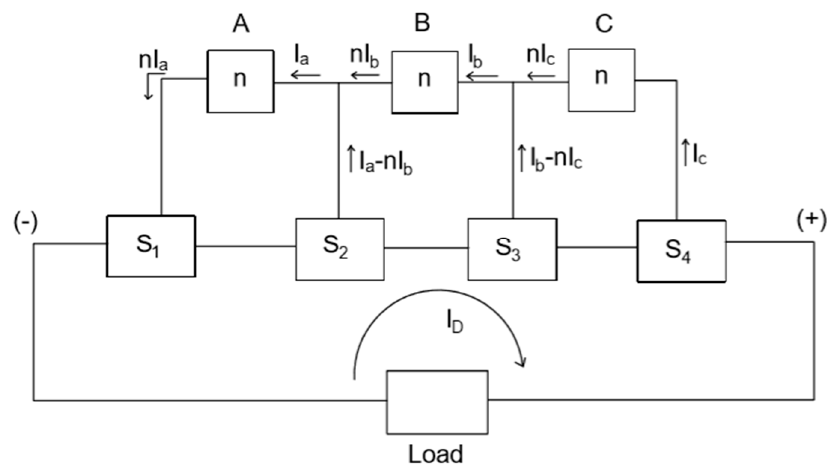
Figure 5. AEQ flow diagram for Examples 1 and 2.